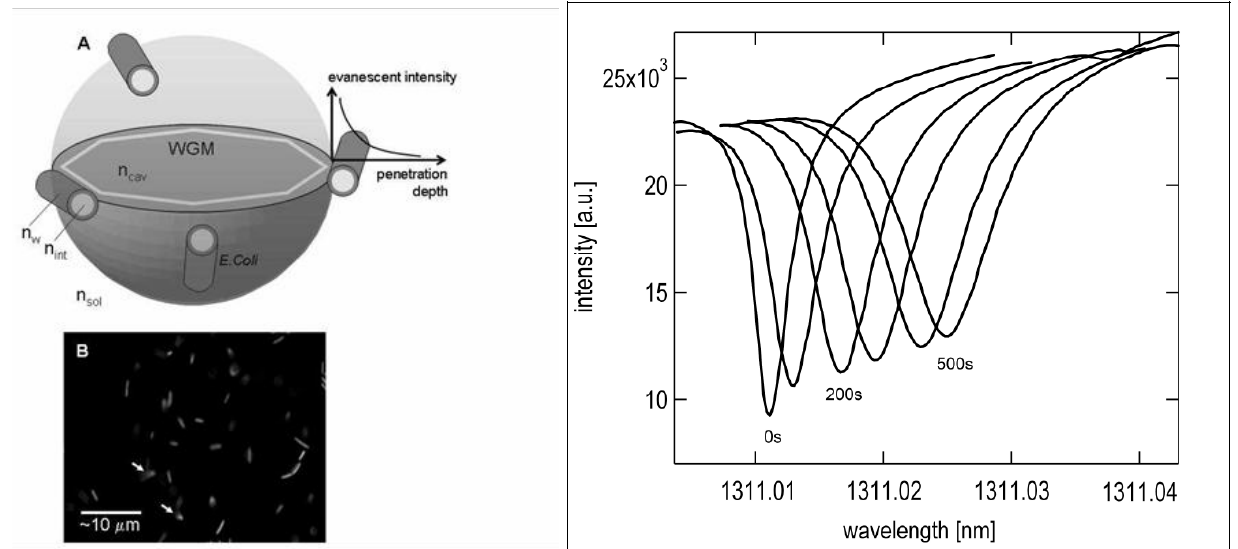
Figure 15 . (A) Sketch of a WGM confined at the equator of the microsphere. N n are the refractive indexes of cavity, surrounding aqueous solution, the bacteria cell wall int and interior (protoplasm) of the bacteria; (B) Fluorescent image of green fluorescent protein (GFP)-labeled bacteria bound to the surface. Only few bacteria (arrows) are bound at their tip; Right: Shift and broadening of the linewidth of the resonance due to adsorption of E.coli . Reproduced with permission from [20] © (2007), Optical Society of